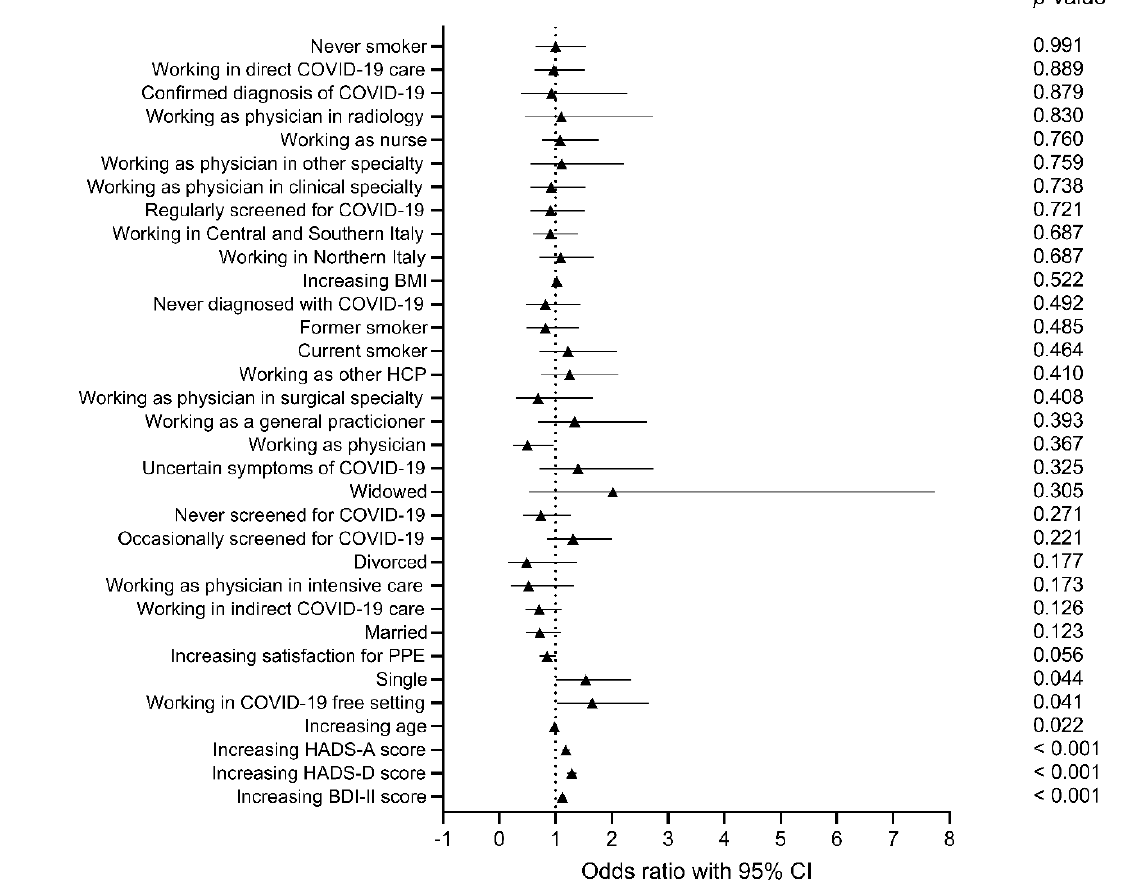
Figure 4. Logistic regression analysis of variables predicting low resilience in male ( A ) and female ( B ) healthcare professionals. Data are expressed as odds ratio and 95% confidence interval. Variables are sorted according to p -values.